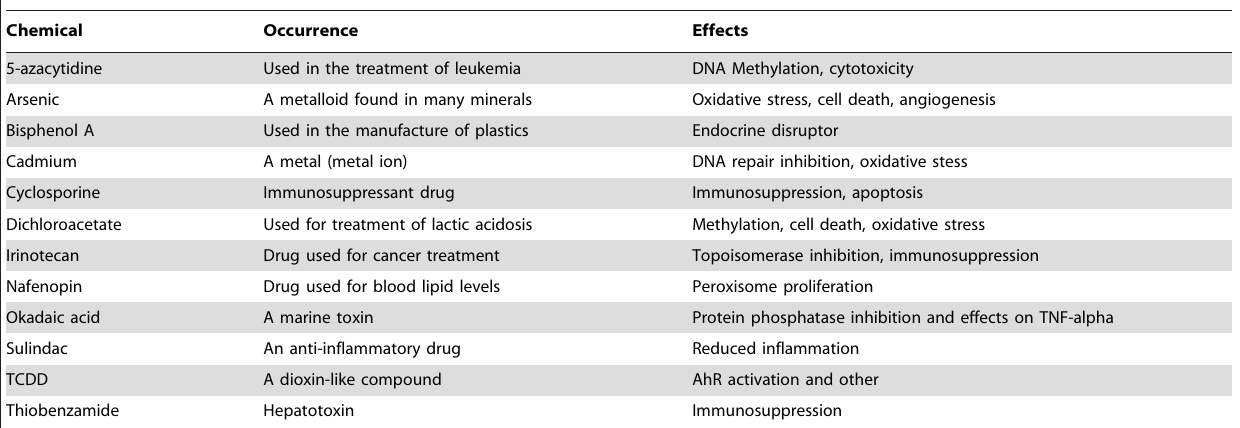
Table 1. Profiles of the new chemicals used for